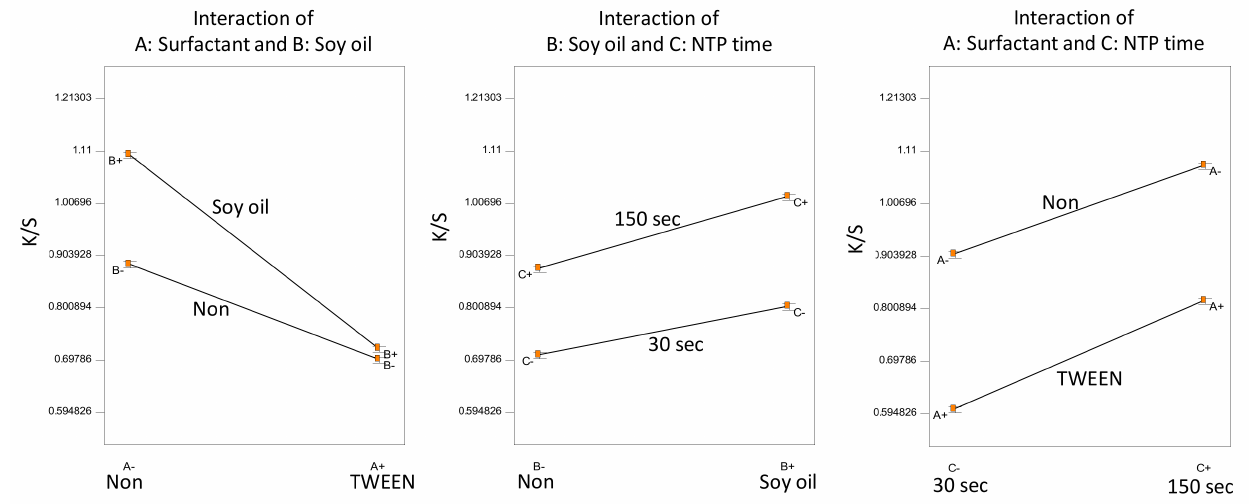
Figure 5. Statistical inference of Experiment D: significant factorial interactions.